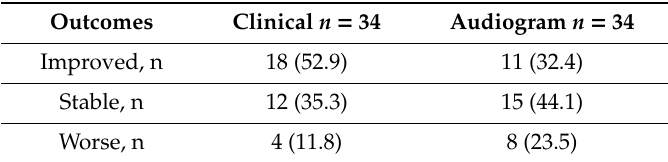
Table 2. Clinical and audiogram outcomes one year after treatment with penicillin G sodium treatment in otosyphilis patients.